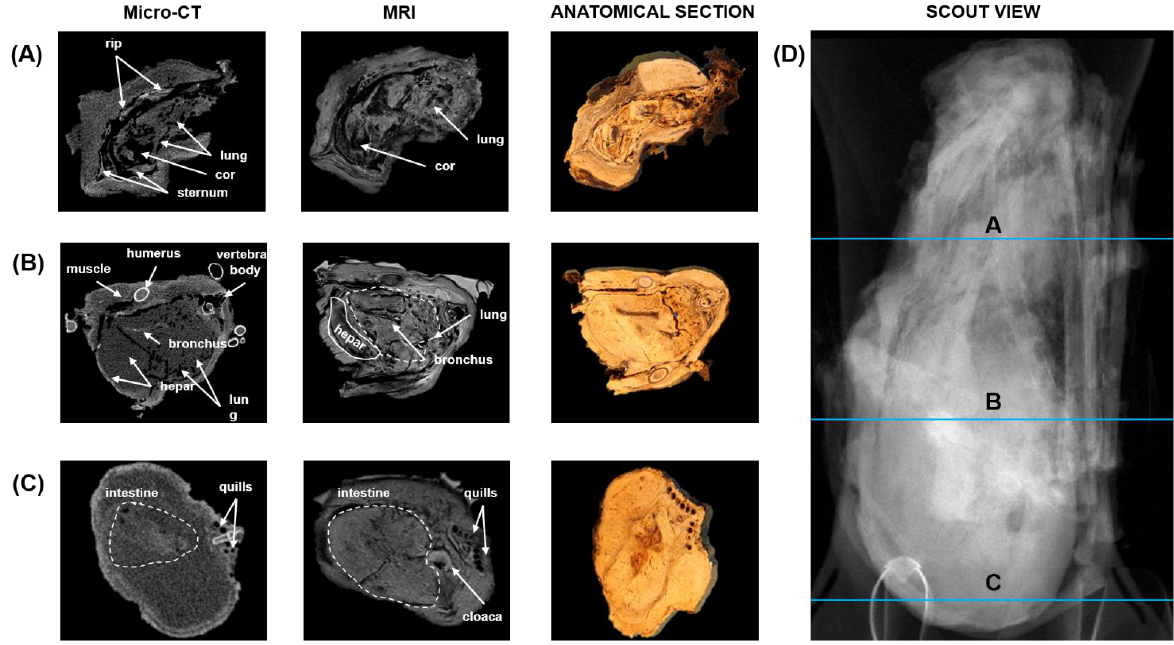
Figure 4. Transversal micro-CT, MRI, and anatomical section images of the trunk at different levels. ( A ) Anatomical section of the trunk at the level of the cor and lung. ( B ) Anatomical section of the trunk at the level of the hepar and lung. ( C ) Anatomical section of the trunk at the level of the cloaca and intestine. ( D ) Scout view of the trunk with lines representing the locations of different levels.